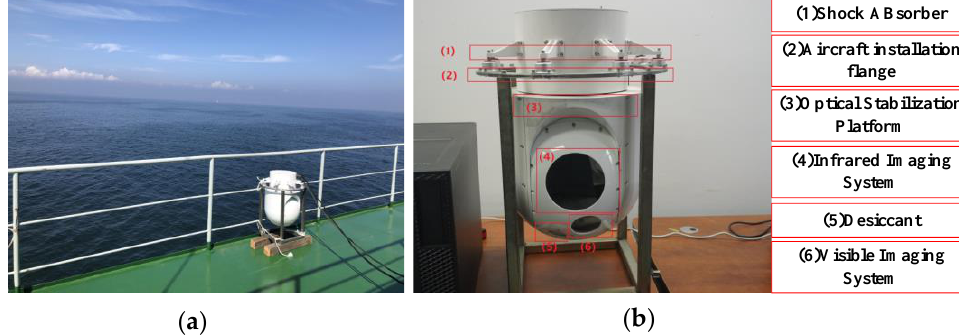
Figure 12. Experimental site and imaging equipment for infrared image acquisition. ( a ) Equipment is collecting infrared images on board around the clock; ( b ) the pod that collects the image, and the important functional blocks of the device are described in the figure.